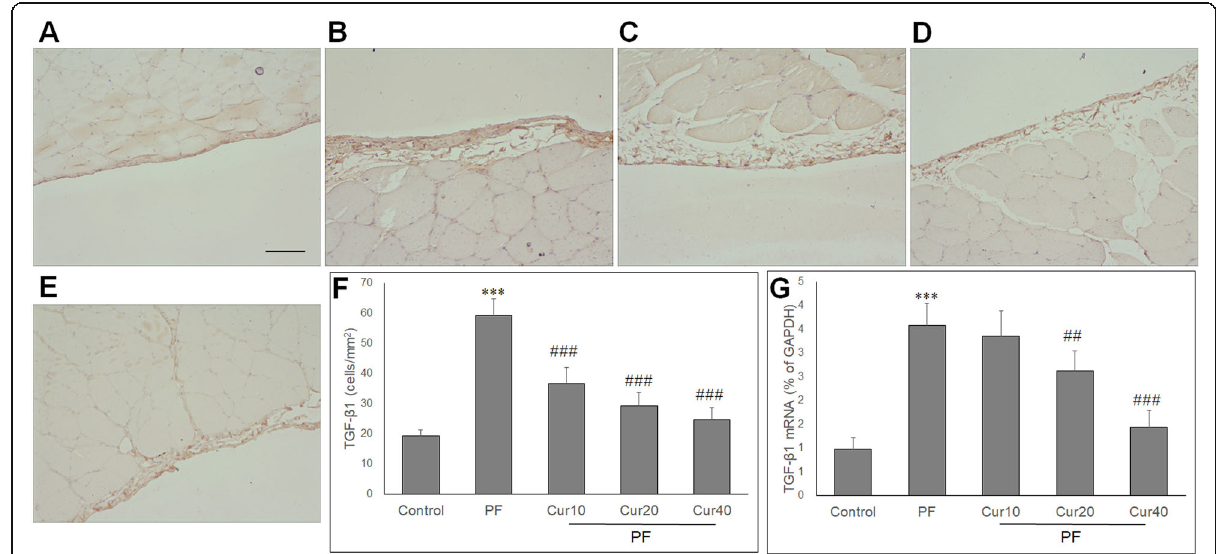
Fig. 3 Effect of curcumin on the expressions of TGF- β 1 in peritoneum of experimental PF model. TGF- β 1-positive cells were occasionally found in the peritoneum of the control group ( a ), but were increased in the PF group ( b ). Curcumin at 10 mg/kg ( c ), 20 mg/kg ( d ) and 40 mg/kg ( e ) all markedly reduced the number of TGF- β 1-positive cells. f Quantification analysis of number of TGF- β 1-positive cells in the peritoneum (cells/mm 2 ) in each group. g Quantitative real-time PCR showed the TGF- β 1 mRNA expression in the peritoneum of each group. ANOVA was performed and followed with Tukey ’ s post hoc test. *** P < 0.001 vs. control group; ## P < 0.01, ### P < 0.001 vs. PF